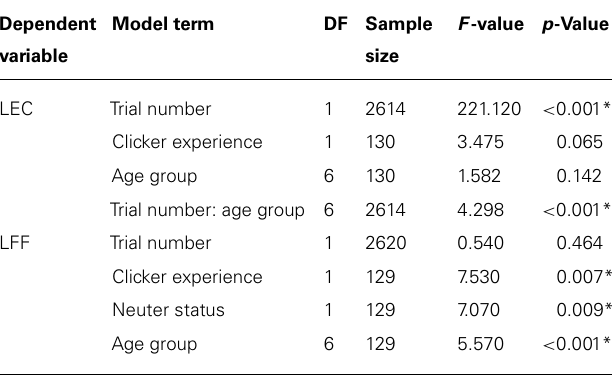
Table 3 | Linear mixed effects models factors affecting learning across trials in latency to eye contact (LEC) and latency to find food